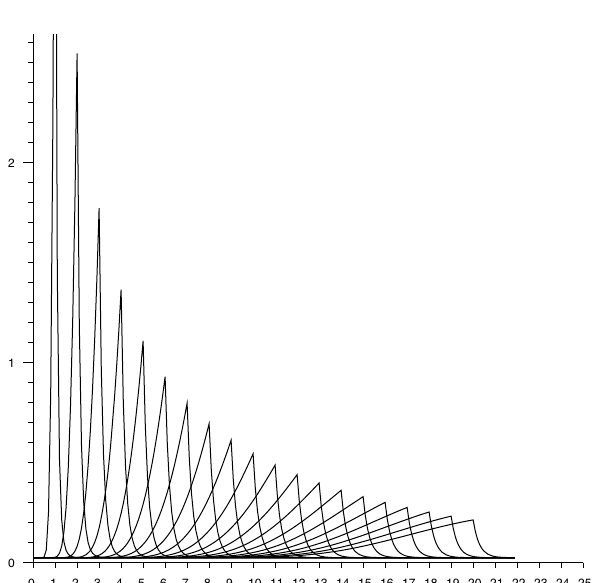
Figure 9. Rate vectors used in updating the Bayesian grid (horizontal axis actual distance—meters). Each curve corresponds to a different value for the reported distance. Curves shown for reported distance of 1 m, 2 m, . . ., 20 m.